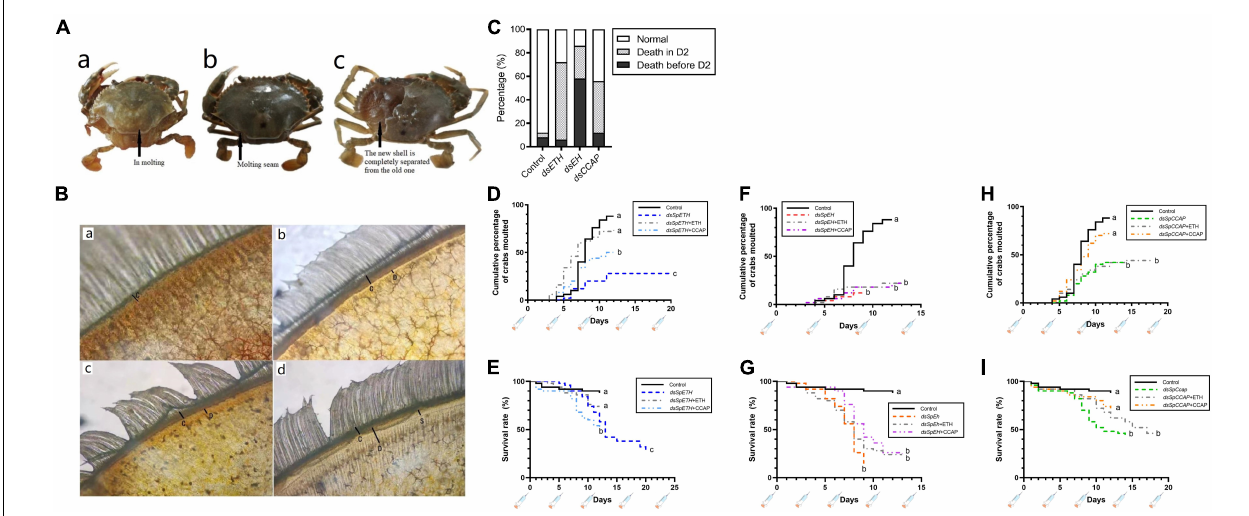
FIGURE 3 | Effect of in vivo dsRNA injection on crabs molting (A,a) Crab that started molting normally; (A,b) crab that unable to initiate molting and died; (A,c) crab died at D2 stage and the exoskeleton of could be peeled off easily. (B) Microscopic examination of a portion of the crab swimming legs at C (B,a) , D0 (B,b) , D1 (B,c) , and D2 (B,d) . The letter C in figures represented the old epidermis, letter D represented the new epidermis, letter S represented the ecdysial suture. (C) Death records of crabs at different stages for the four groups injected with dsGFP , dsETH , dsEH , and dsCCAP , respectively ( n = 50). (D) The cumulative percentage of groups injected with dsGFP , dsETH , dsETH + ETH and dsETH + CCAP, respectively, at D0 stage. (E) The survival rate of groups injected with dsGFP , dsETH , dsETH + ETH and dsETH + CCAP respectively at D0 stage. (F) The cumulative percentage of groups injected with dsGFP , dsEH , dsEH + ETH and dsEH + CCAP respectively at D0 stage. (G) The survival rate of groups injected with dsGFP , dsEH , dsEH + ETH and dsEH + CCAP respectively at D0 stage. (H) The cumulative percentage of groups injected with dsGFP , dsCCAP , dsCCAP + ETH and dsCCAP + CCAP respectively at D0 stage. (I) The survival rate of groups injected with dsGFP , dsCCAP , dsCCAP + ETH and dsCCAP + CCAP respectively at D0 stage. Statistically significant differences ( P ) between the control and any knockdown conditions were found via a log-rank (Mantel-Cox) test and are indicated by different